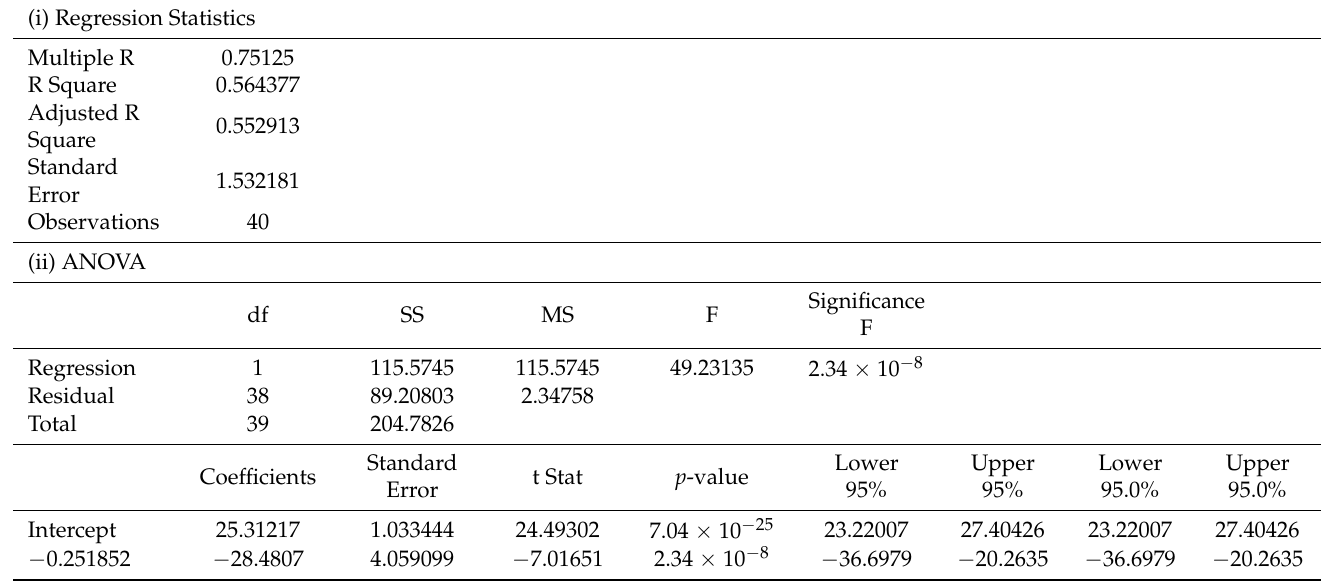
Table A3. Regression Statistics between LST and NDVI for 2000.